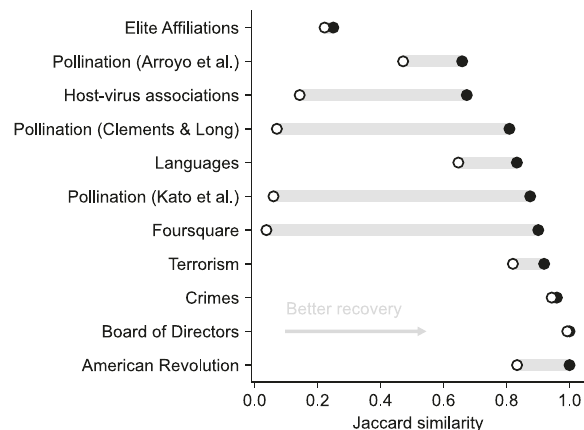
Fig. 4 Quality of the planted interaction reconstruction in projected bipartite networks. Empty symbols show the Jaccard similarity of the higher-order interactions reconstructed with the maximal clique decomposition. Filled symbols depict the same quantity for the reconstruction given by our method (best model fi t). Our method improves on the baseline in every case. Detailed numerical results are reported in Supplementary Table